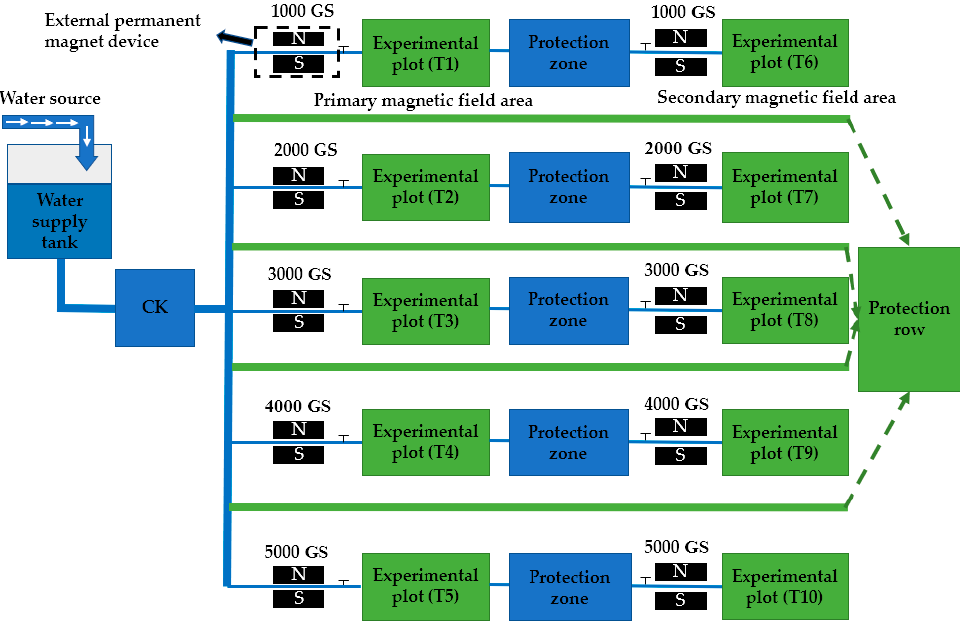
Figure 3. Schematic diagram of magnetization installation and layout in field plots.